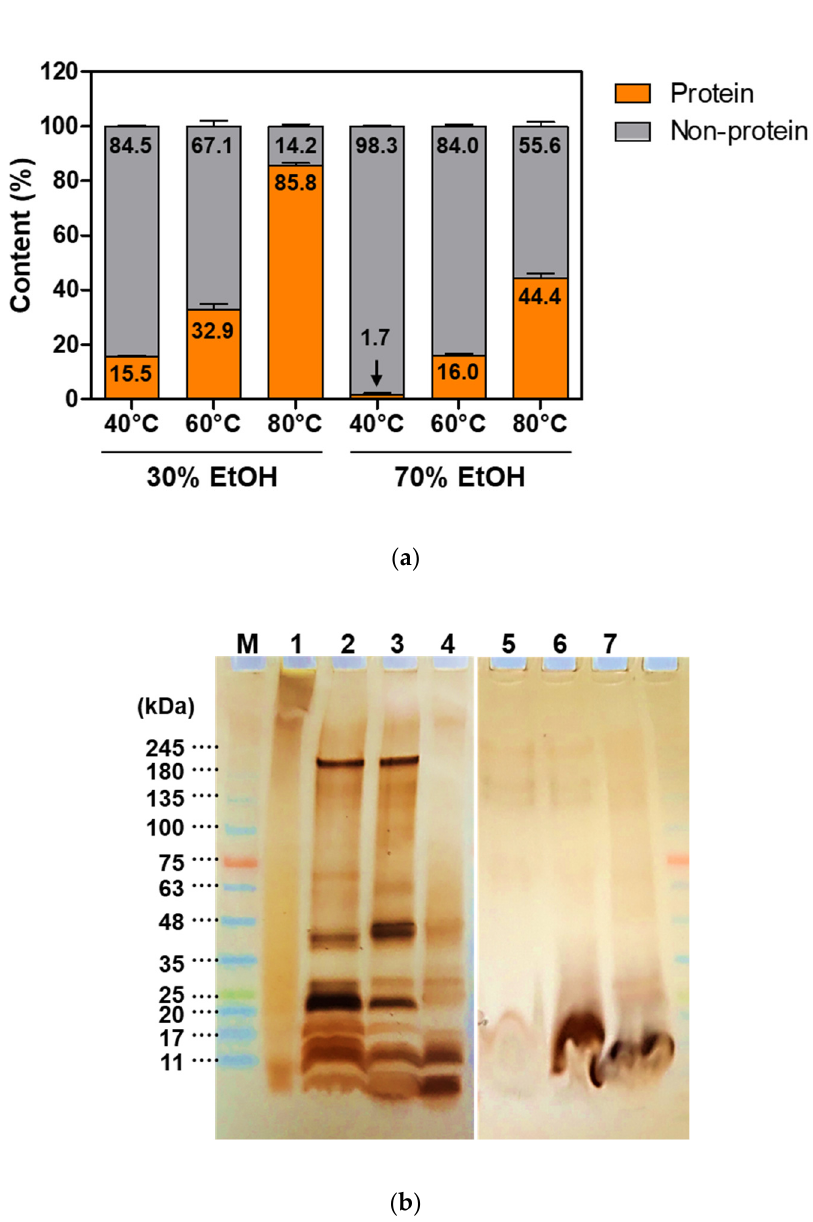
Figure 3. Effects of extraction conditions on protein content (%) and molecular weight of proteins. ( a ) Percentage of protein and non-protein fractions included in the extracts. ( b ) SDS-PAGE results for various cocoon extracts. Lane “M” and ”1”–”4” indicate marker (M), silk sericin extracted by using a hot water system (1), cocoon extracts prepared by 30% ethanol (EtOH) at 40 °C (2), 60 °C (3), 80 °C (4), respectively. Lanes ”5”–”7” indicate cocoon extracts prepared by 70% EtOH at 40 °C (5), 60 °C (6), 80 °C (7), respectively.